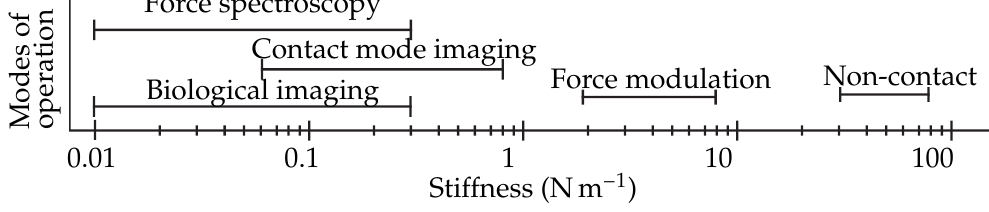
Figure 1. The range of stiffness for the AFM cantilever for different imaging modes.